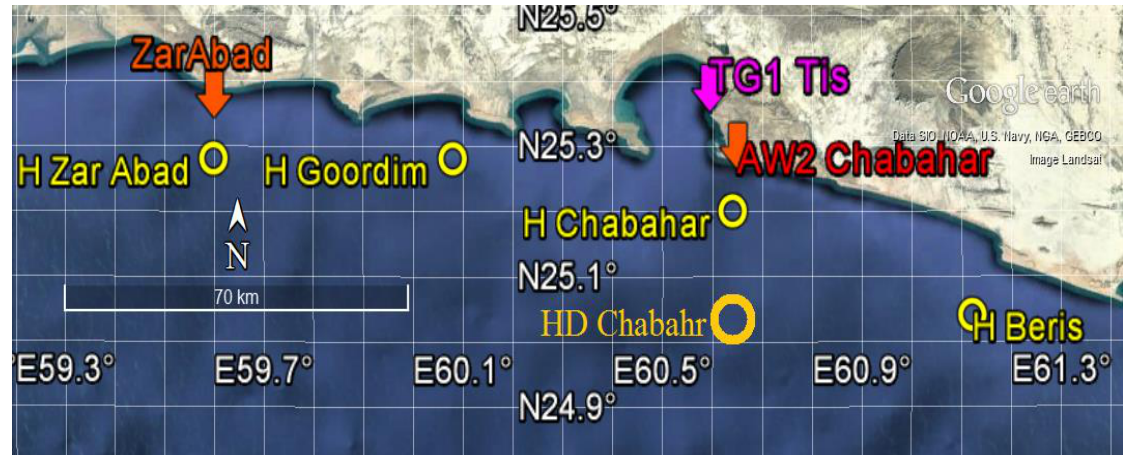
Figure3. Locations of the data collection stations